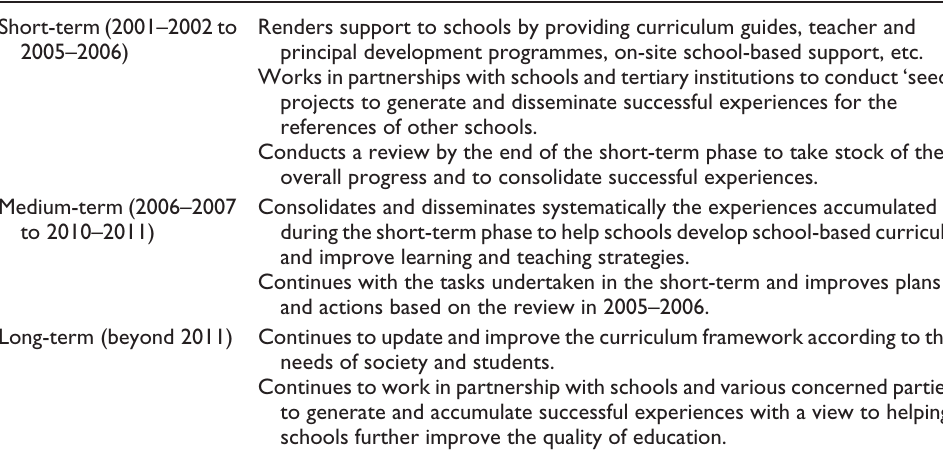
Table 2. The development strategies adopted by the government at different stages of implementation (adapted from Curriculum Development Council